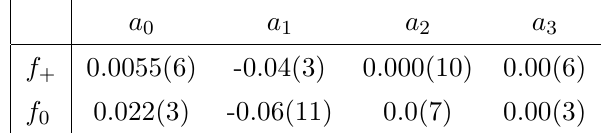
Table 5 . Coe(cid:14)cients of f + and f 0 in the expansion from eq. (5.10) with n = 3 and f lat =